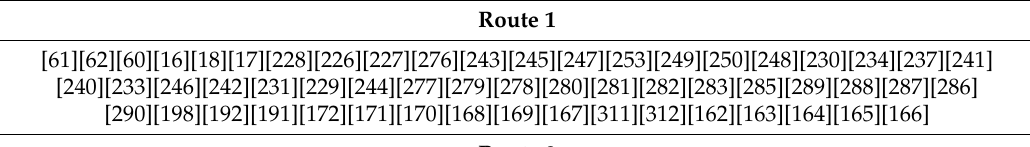
Table 3. The route order for retail stores delivered in Route 1, 8, based on ROPIRPSDR. Route